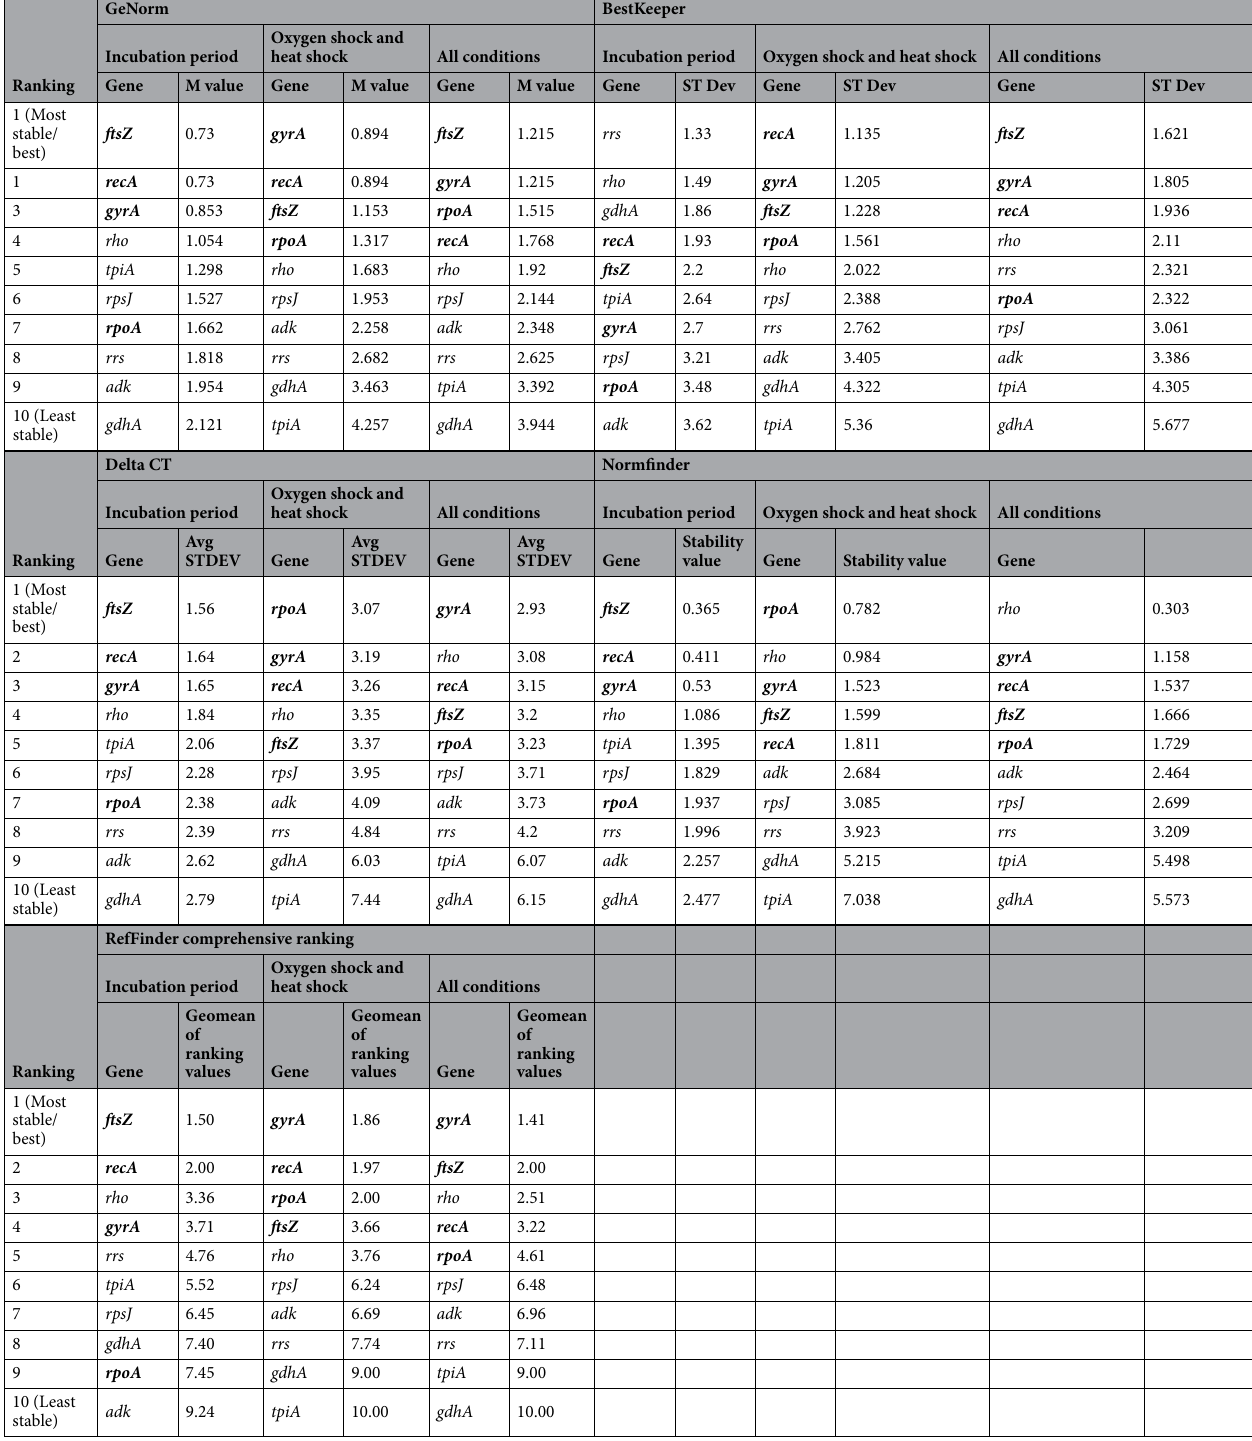
Table 4. Expression stability ranking of the ten candidate reference genes according to geNorm, BestKeeper, NormFinder, Delta CT, and the RefFinder comprehensive analysis. These analyses were performed using